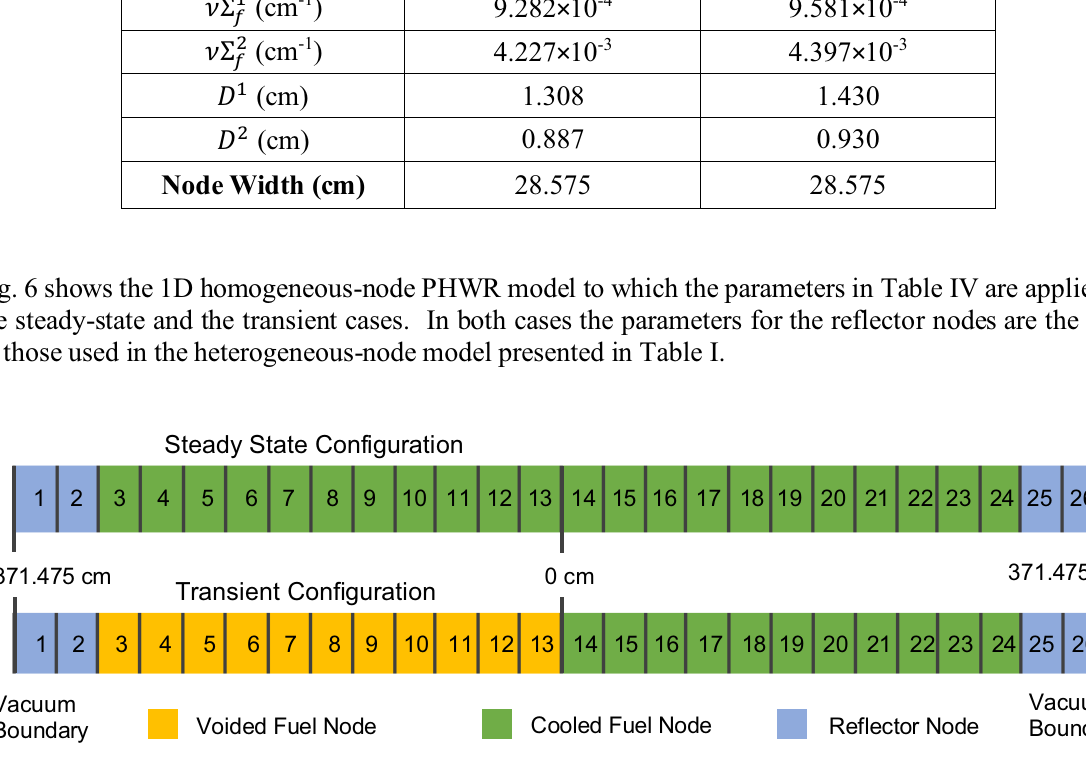
Figure 6. One-dimensional Homogeneous-Node PHWR